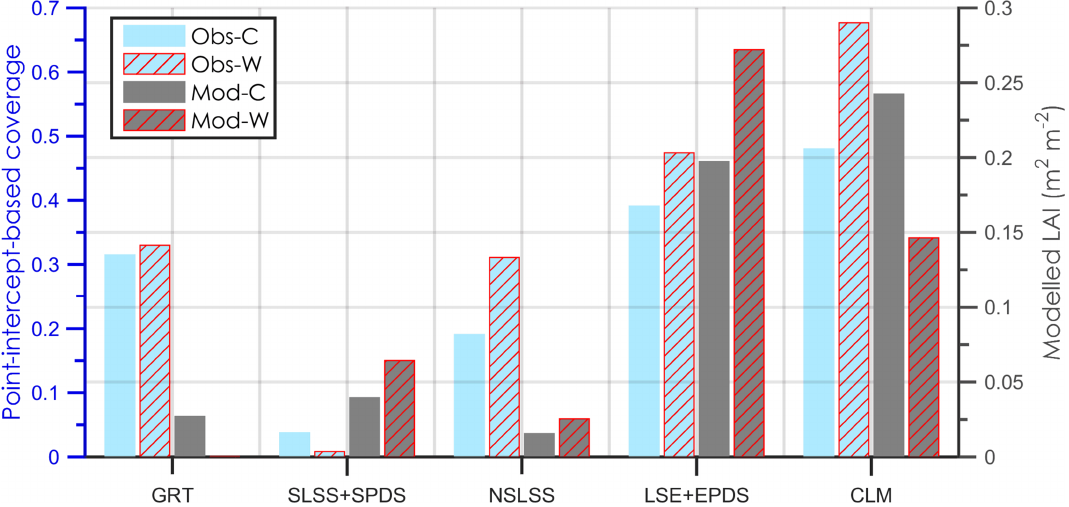
Figure 3. Point-intercept-based vegetation coverage and modelled leaf area index (LAI,m 2 m − 2 ) averaged for the growing season 2010 and 2012 for the control (C) and warming (W) treatments in the Abisko tundra heath. Different y axes are used for the observed (Obs) and the modelled (Mod) coverage to allow comparison of warming effects. GRT: graminoid tundra; SLSS: Salix , low shrubs summergreen; SPDS: summergreen prostrate dwarf shrubs; NSLSS: non- Salix , low shrubs summergreen; LSE: low shrubs evergreen; EPDS: evergreen prostrate dwarf shrubs; CLM: cushion forbs, lichens and moss